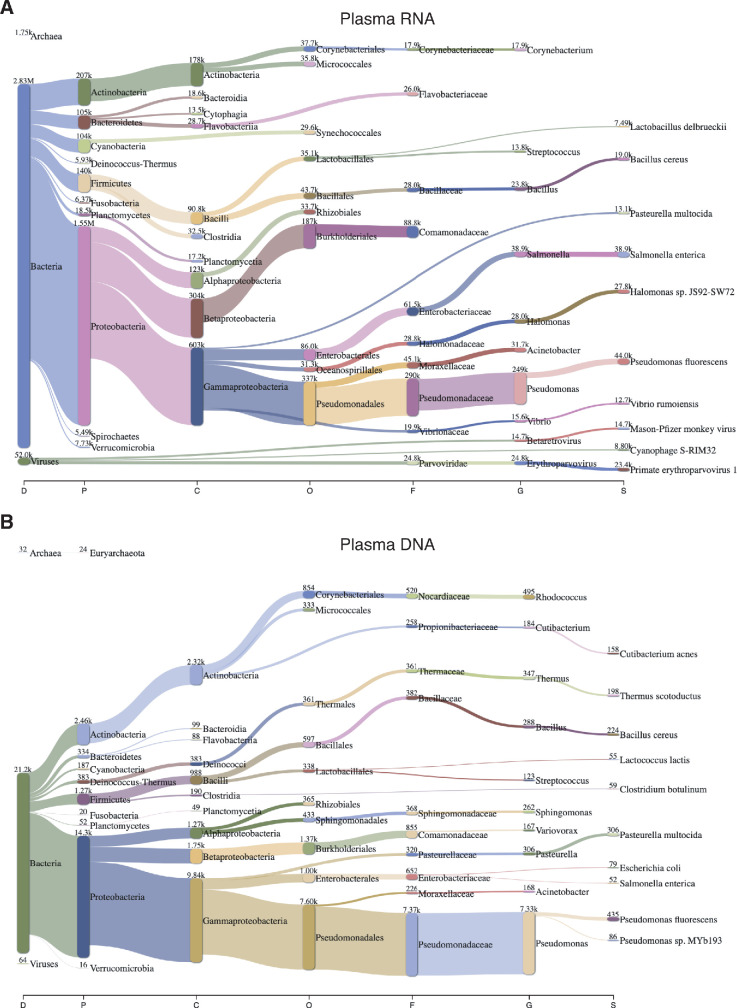
Sankey diagram of reads assigned to bacteria, archaea, and viruses from combined datasets of (A) DNase-treated plasma RNA (n = 15) and (B) NaOH-treated plasma DNA (n = 4).The diagram shows the flow of mapped reads from the most general (left) to most specific (right) taxonomic classification (abbreviations: D, Domain; P, Phylum; C, Class; O, Order; F, Family; G, Genus; S, Species). The width of the flow is proportional to the number of reads, which is indicated at the top of each node.